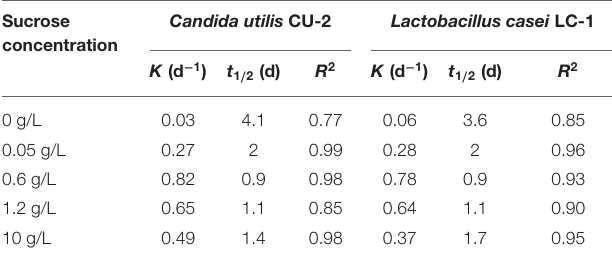
TABLE 1 | First-order kinetic rate constant ( k ) and half-life ( t 1 / 2 ) for E2 degradation by Candida utilis CU-2 or Lactobacillus casei LC-1. Candida utilis CU-2 Lactobacillus casei Sucrose concentration